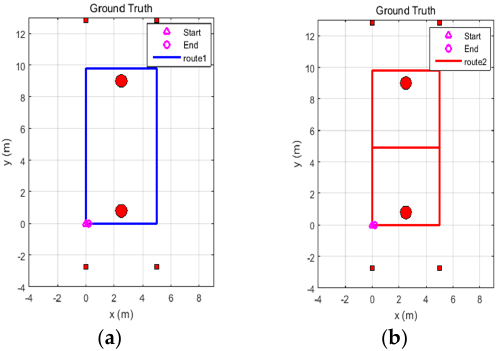
Figure 8. Map of the experiment setup and the reference trajectory. ( a ) Route 1; ( b ) Route